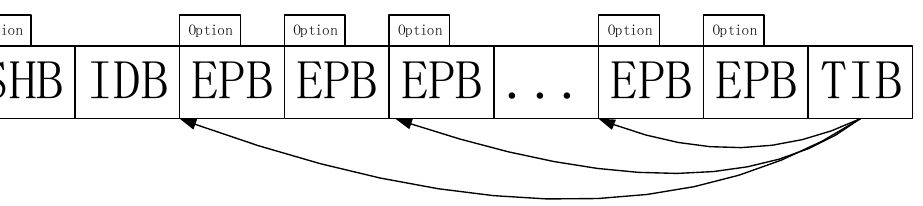
Figure 4. The packet storage format.